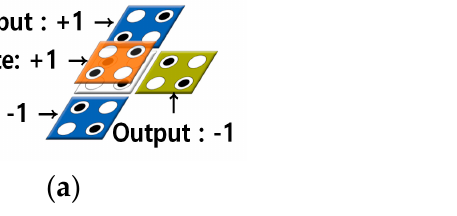
Figure 4. Multilayer based AND/OR gate: ( a ) AND gate, ( b ) OR gate.